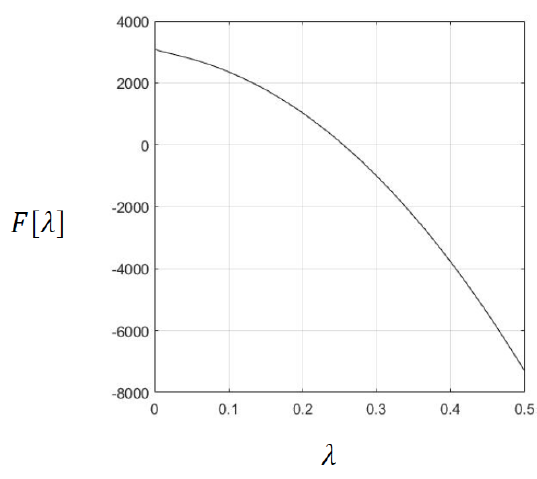
Figure 4. The characteristic Equation (13) as a function of the eigenvalue λ . The root is at the point where F [ λ ] = 0 (i.e., λ = 0.255 ) .